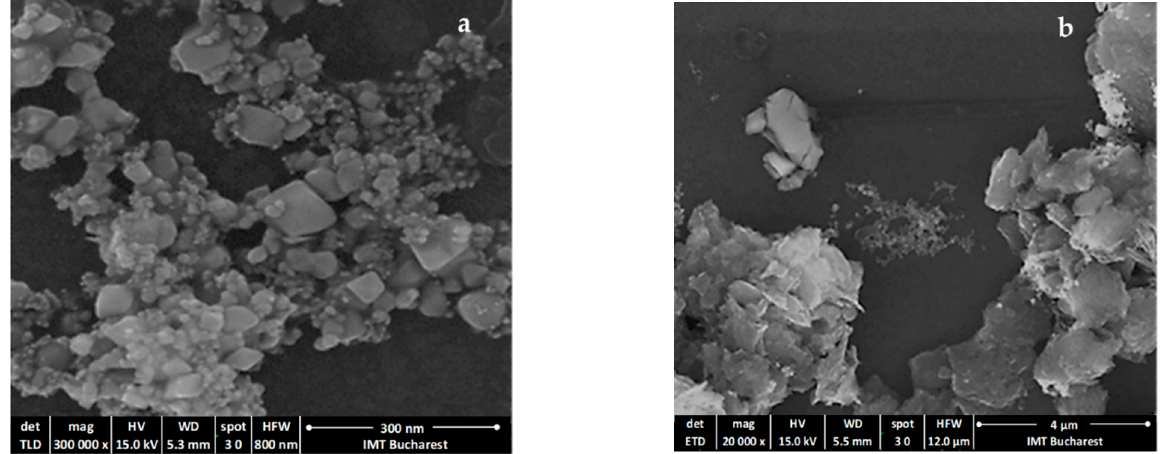
Figure 5. Scanning electron micrographs of the CNHox/GO/SnO 2 /PVP = 1/1/1/1 at 1:1:1 w/w / w/w ratio: ( a ) magnification 300,000; ( b ) magnification